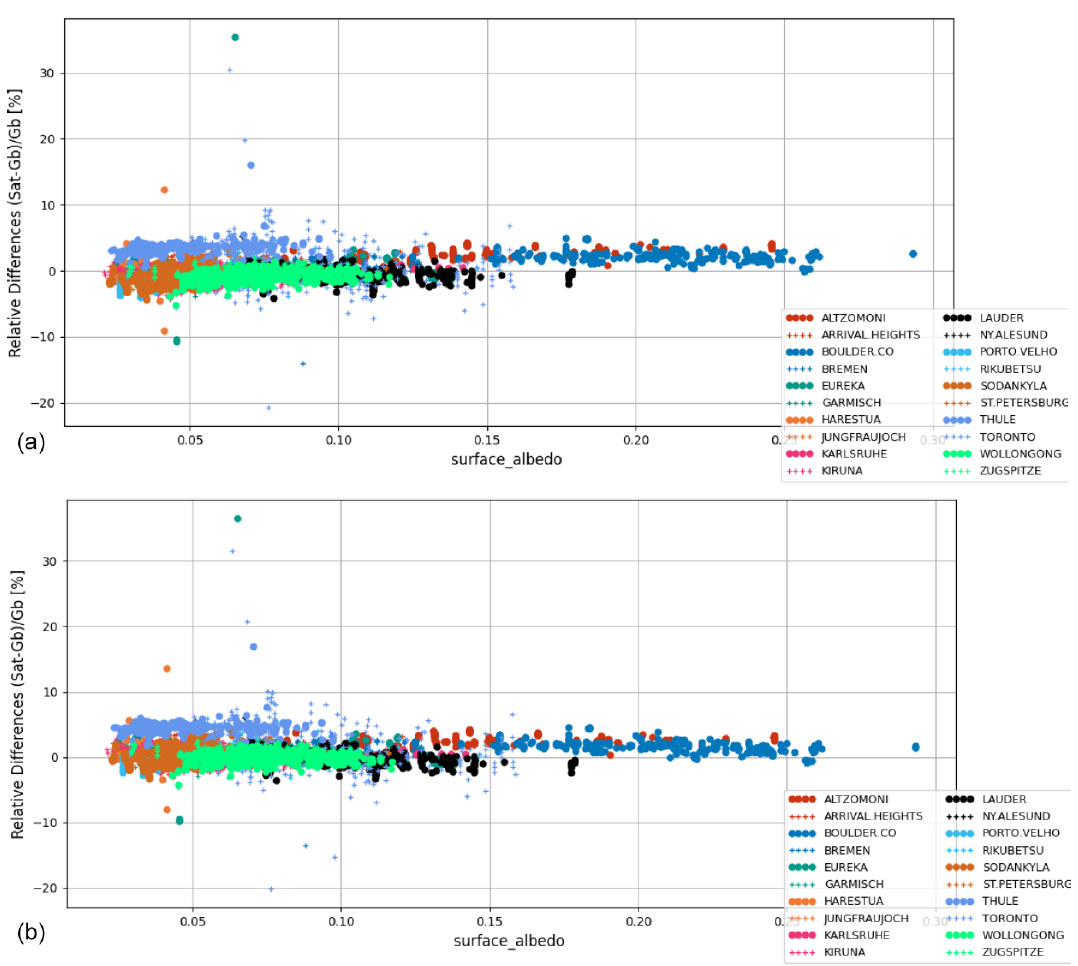
Figure 10. Relative biases between co-located S5P (standard XCH 4 product – a ; bias-corrected XCH 4 product – b ) and NDACC XCH 4 data smoothed with S5P a priori and additionally smoothed with the S5P column-averaging kernel are plotted as a function of the surface albedo retrieved by S5P at 20 NDACC stations within the period between November 2017 and September 2020. Spatial co-location with radius of 100km and time of ± 3h around the satellite overpass was